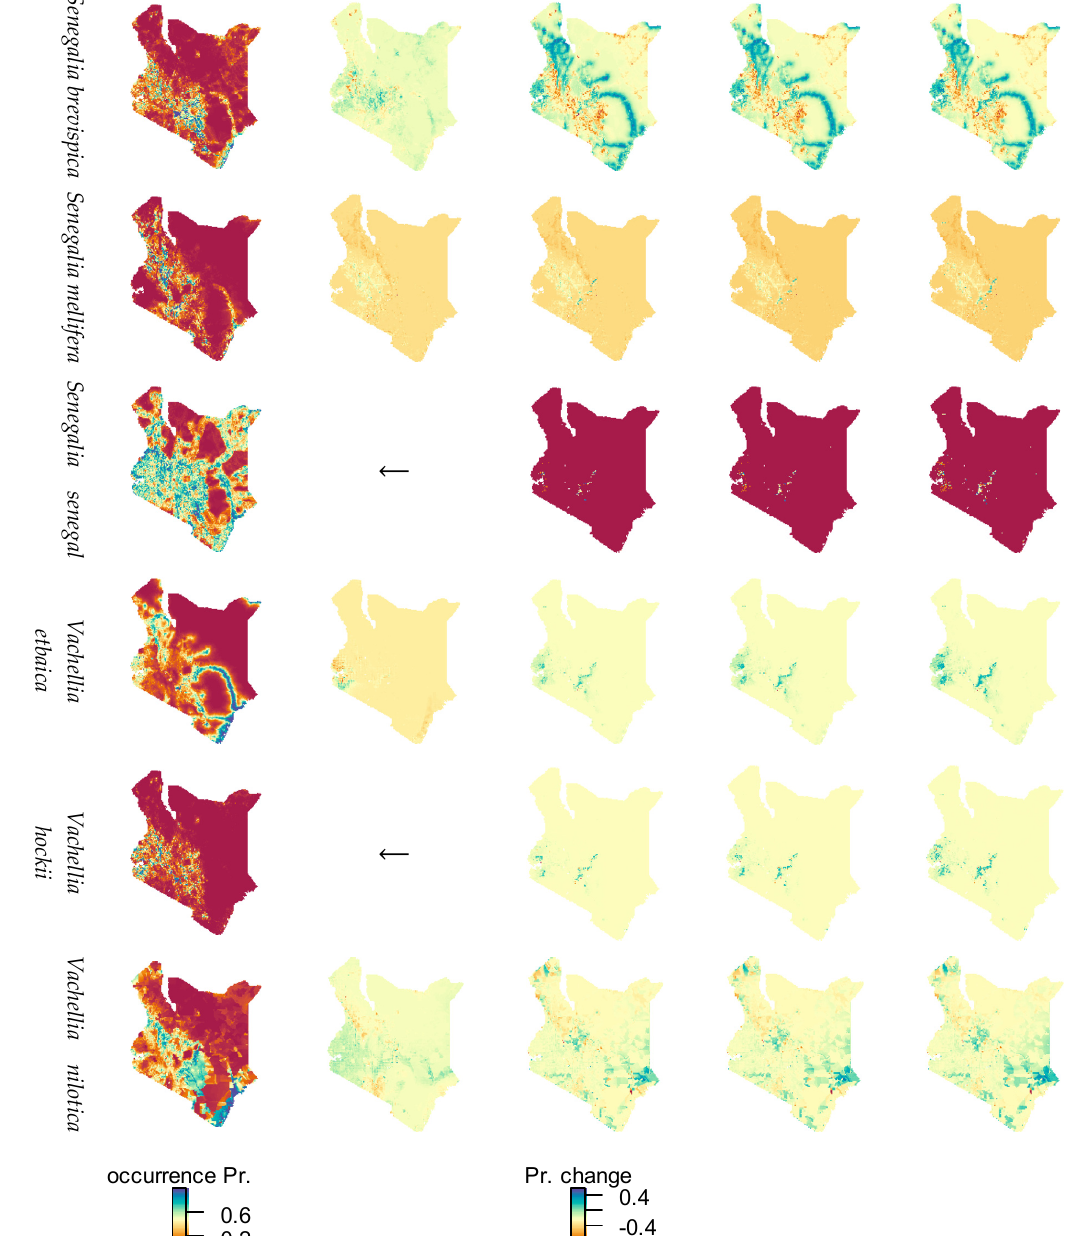
Figure 6. Predicted occurrence probability of 9 species by MaxEnt at present and changes in 2050, under RCP 4.5 and 3 SSP scenarios.